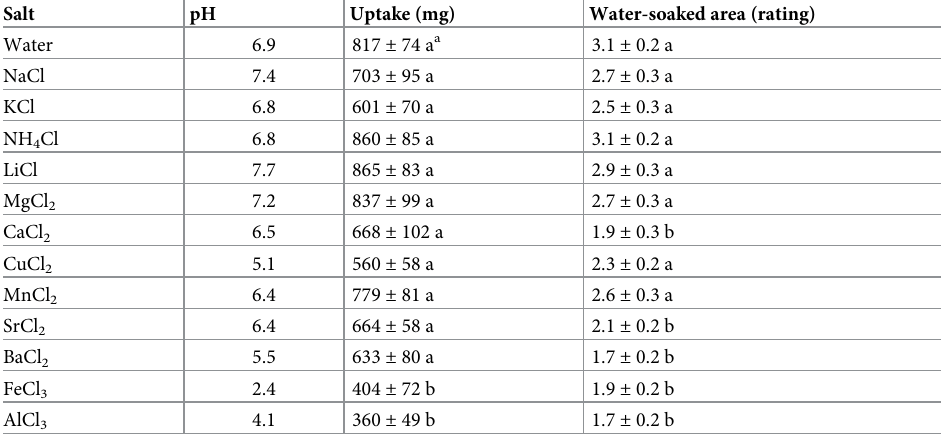
a Means followed by the same letter do not differ significantly from the control, Dunnett ‘s test at p = 0.05. Water soaking was indexed using a five-score rating scale: score 0, no water soaking; score 1, < 10% of the surface area water-soaked; score 2, 10 to 35%; score 3, 35 to 60%; score 4 > 60%.